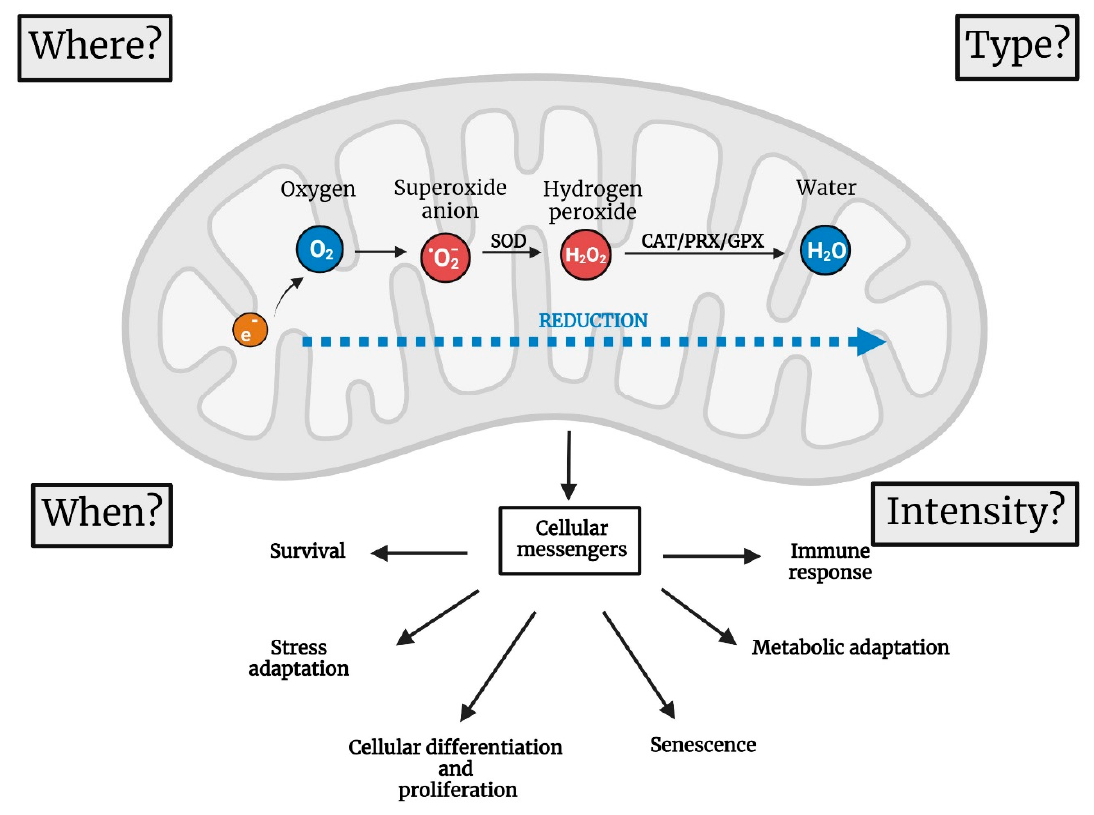
Figure 2. Mitochondrial reactive oxygen species (ROS) are important cellular messengers, but understanding their role in cellular physiology requires consideration of four questions: (1) Where is the signal produced?; (2) When is the signal produced?; (3) What type of signal is produced?; and (4) What is the intensity of the signal? These four characteristics of an mtROS signal determine the downstream effects it can induce. Antioxidants act as essential regulators of ROS signalling by either transforming one signal into another, regulating the intensity of the signal or turning off the signal. The figure depicts some examples of the processes controlled by mtROS signalling. For more information, please refer to the main text.